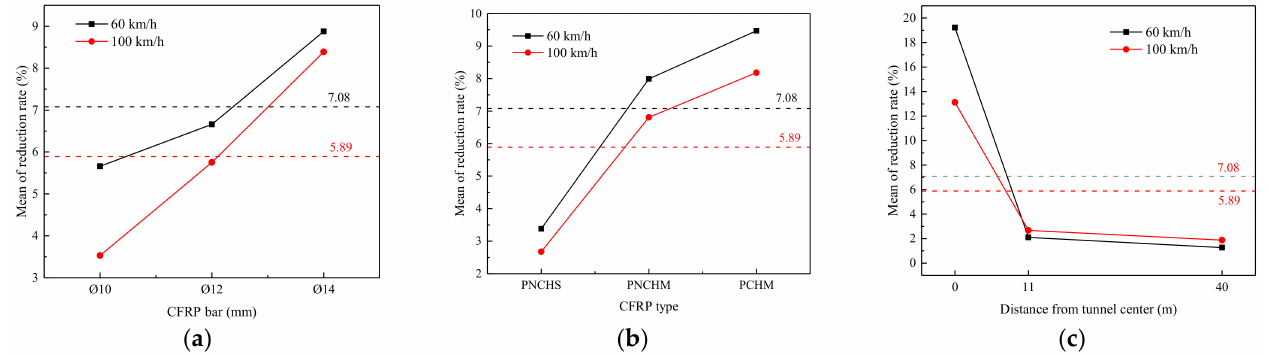
Figure 23. Reduction rate for each selected factor. ( a ) CFRP content; ( b ) CFRP type; ( c ) distance from the tunnel center.